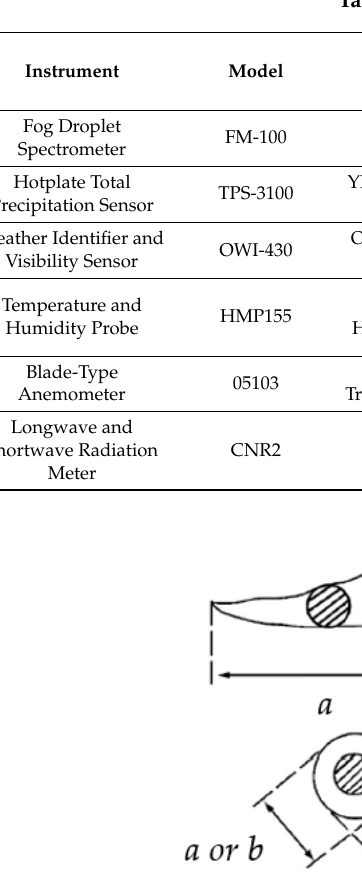
Table 1. List of instruments used.